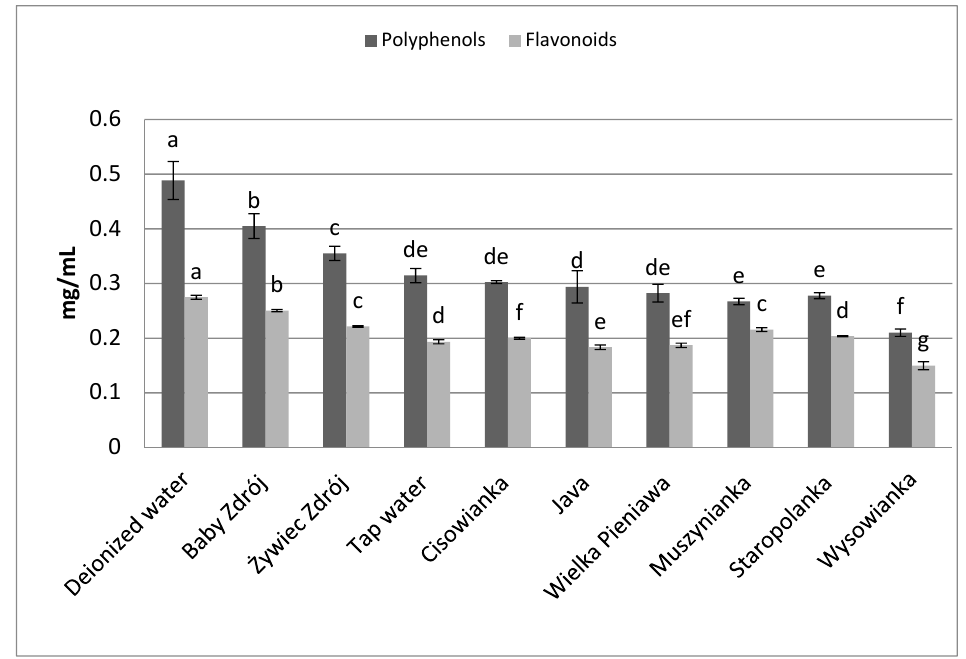
Figure 5. The effect of water mineralization on the extraction of active substances from chamomile inflorescences. Data are shown as mean ± SD. Different letters (a, b, c, etc.) show a significant difference with p < 0.05. The differences relate to each group of compounds separately.